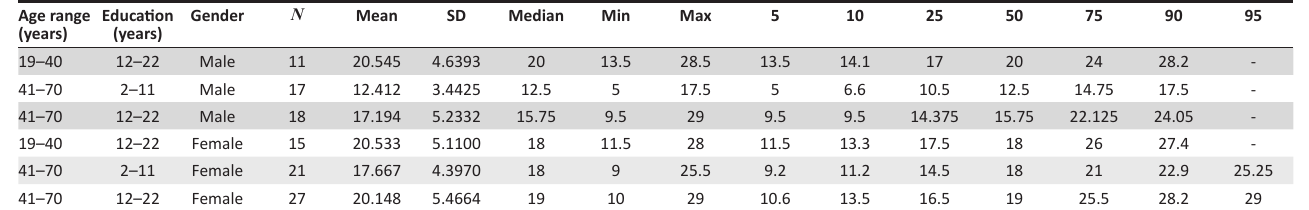
TABLE 6: Hooper Visual Organization Test normative performance of a South African sample stratified by age, education and gender (percentiles). Age range Education (years)